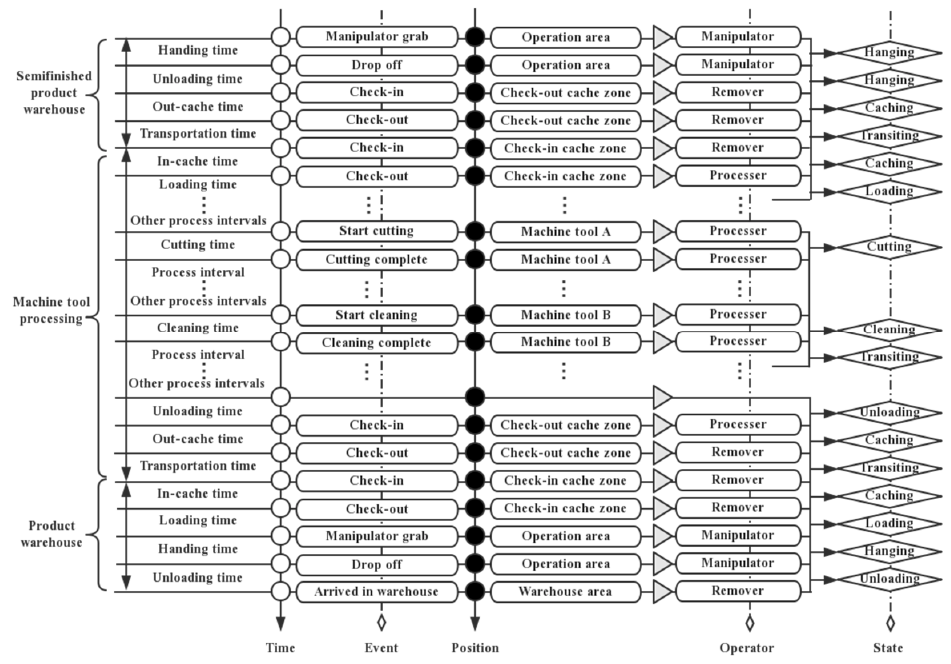
Figure 7. Process flow monitoring diagram based on RFID configuration for producing single crystal silicon chips.